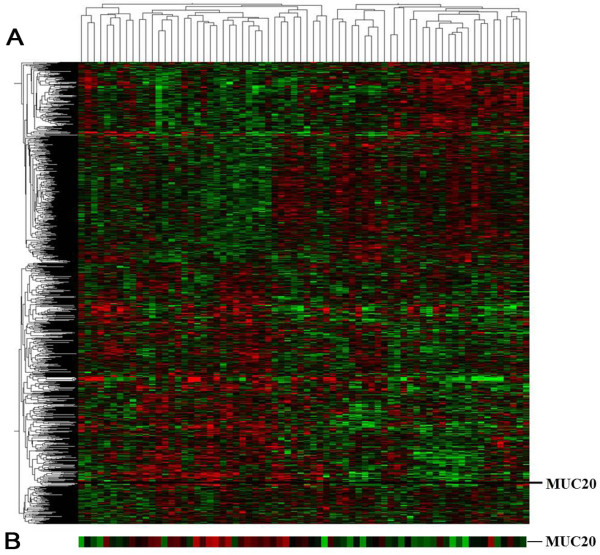
Displays the gene expression profiling of 81 CRC tissues. (A) A view of 887 significantly up-expressed genes and 649 significantly down-expressed genes by hierarchical clustering analysis. Each column represents a sample, and each row represents a gene. Gene expression is depicted in red (high expression) and green (low expression), respectively. Patients with poor prognosis mainly focus on the left side, and patients with good prognosis mainly focus on the right side. (B) Expanded view of MUC20 cluster.